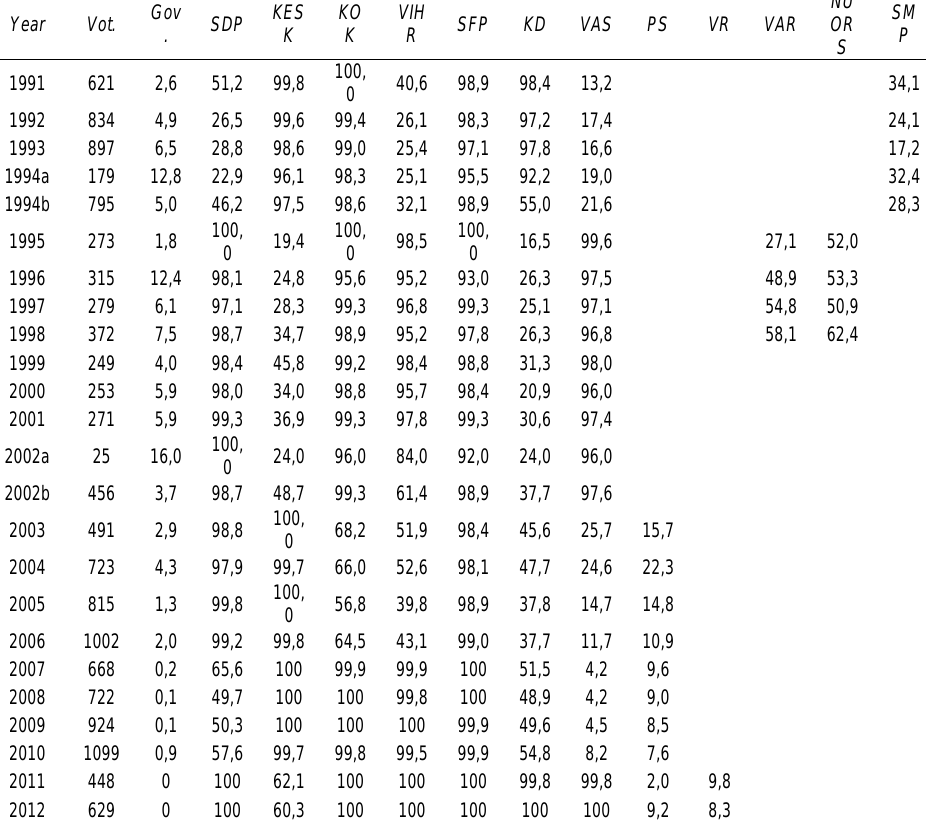
Table 1. Government Groups’ voting unity and shares (%) of plenary votes during 1991-2012, where other PPGs voted with the government